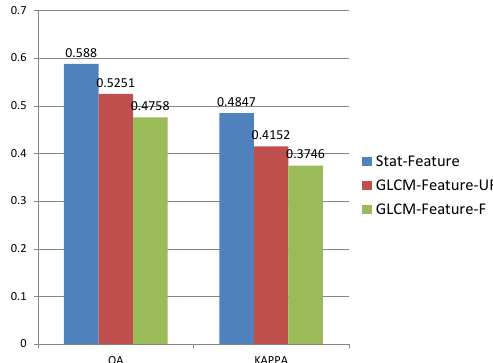
Figure 7. Classification evaluation using OA and kappa coefficient as the evaluation metrics.